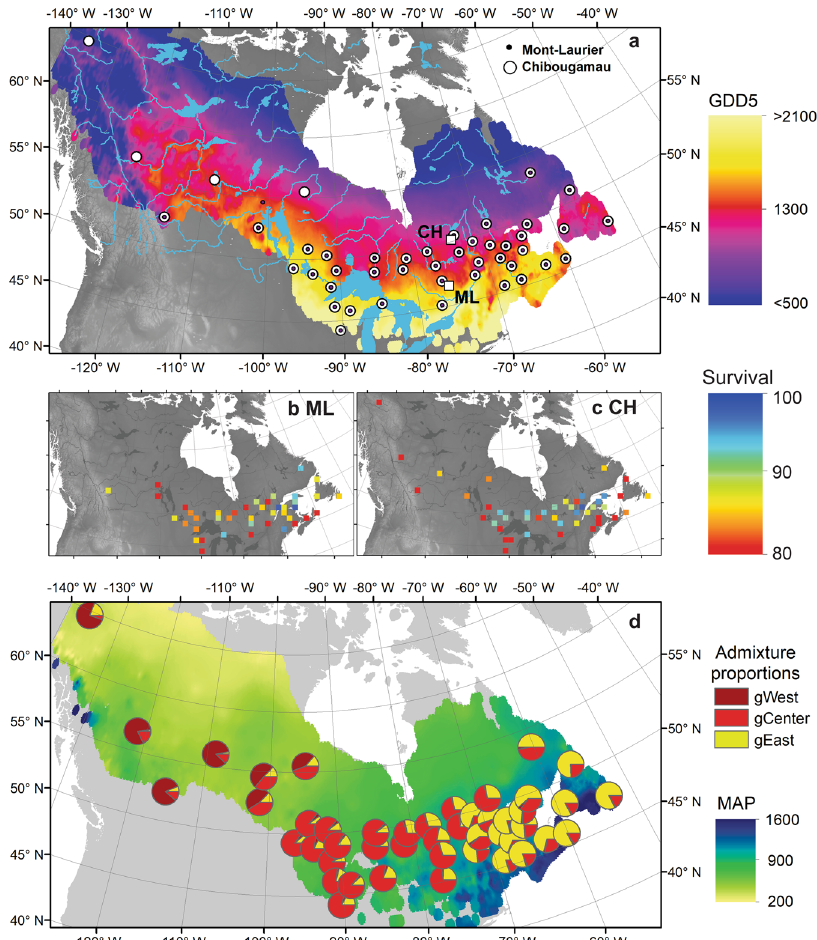
Fig. 1 Origin of sampled black spruce provenances. a Squares: Locations of the Mont-Laurier (ML) and Chibougamau (CH) common gardens along with the locations of the black spruce seed origins (dots), superposed on the species ’ range limits 90 . Background colors: mean annual growing degree days above 5 °C (GDD5, °C) computed over 1961 – 1990. b , c Percent survival (%) of individuals as of year of sampling in each common garden as a function of the seed provenance distribution. d Pie chart: Averaged genetic admixture proportions on a given cluster corresponding to Western (gWest), Central (gCenter), and Eastern (gEast) lineages. The admixture proportions are used as a proxy to describe among population genetic differences. Background colors: mean annual precipitation (MAP,